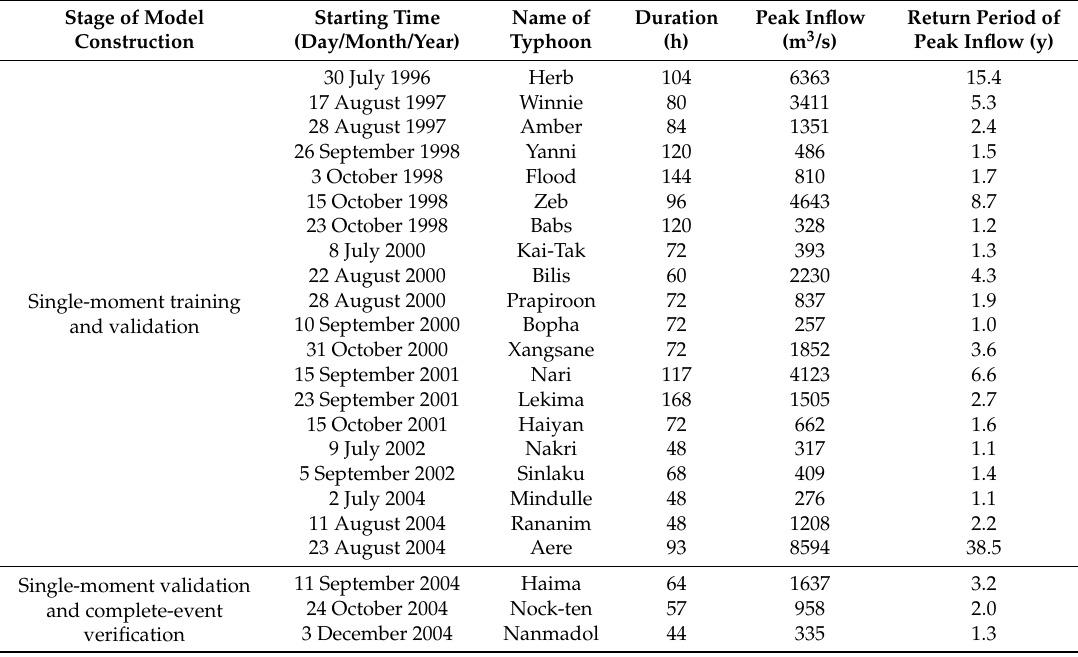
Table 1. Adopted typhoon events for construction of the BPNN-based water level simulation model. Stage of Model